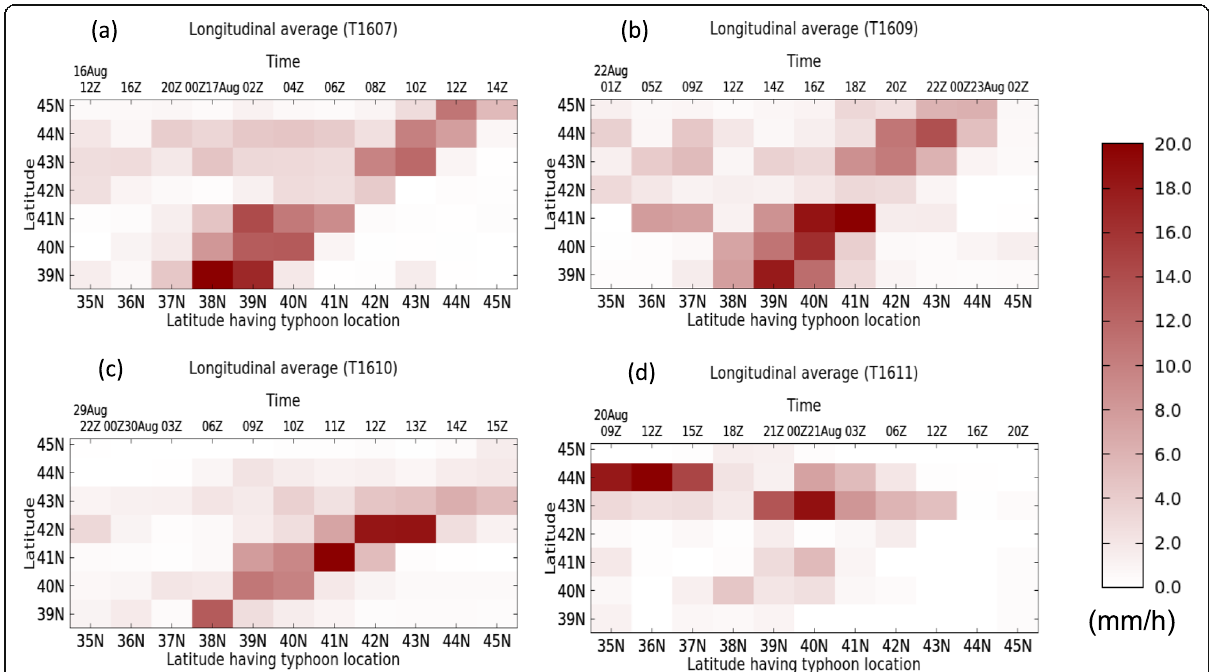
Fig. 8 Longitudinal averaged precipitation amount at different latitudes from a Typhoon Chanthu, b Typhoon Mindulle, c Typhoon Lionrock, and d Typhoon Kompasu passing through different latitudes starting from 39 to 45 N